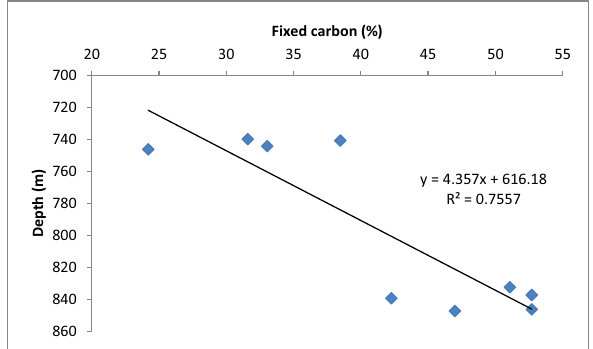
Fig. 1 Variation in fixed carbon with